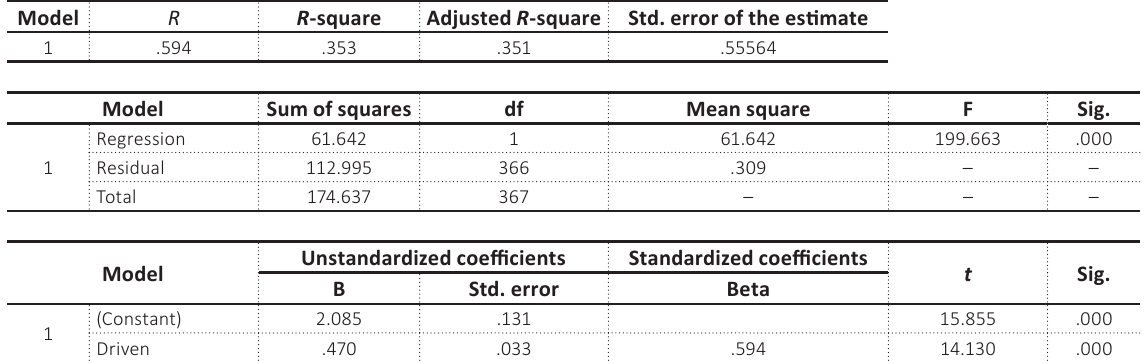
Table 5. Model summary, ANOVA and coefficients of 2nd hypothesis